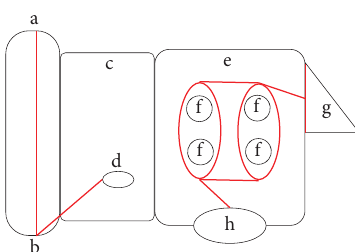
Figure 1: Graphical representation of procedure and radio- frequency ablation route. (a) Superior vena cava. (b) Inferior vena cava. (c) Right atrium. (d) Coronary sinus. (e) Left atrium. (f) Pulmonary venous orifice. (g) Left atrial appendage. (h) Mitral